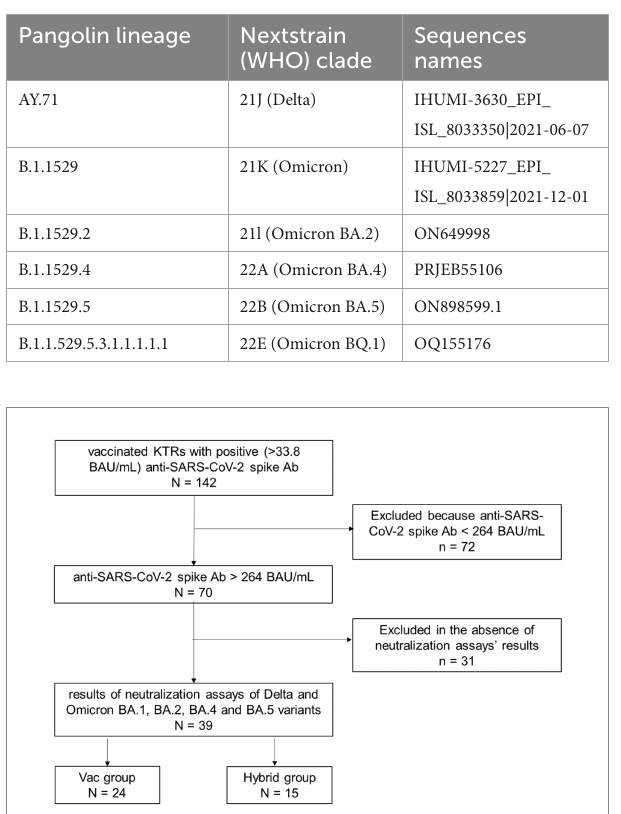
FIGURE 1 Flow chart. Between August 23, 2021 and April, 262,022, 142 kidney transplant recipients (KTRs) received at least one dose of vaccine against SARS-CoV-2 before sampling for serology and had positive (> 33.8 binding antibody (Ab) units (BAU)/mL) anti-SARS-CoV-2 spike Ab in our laboratory. Of the 142 KTRs, 72 had anti-spike